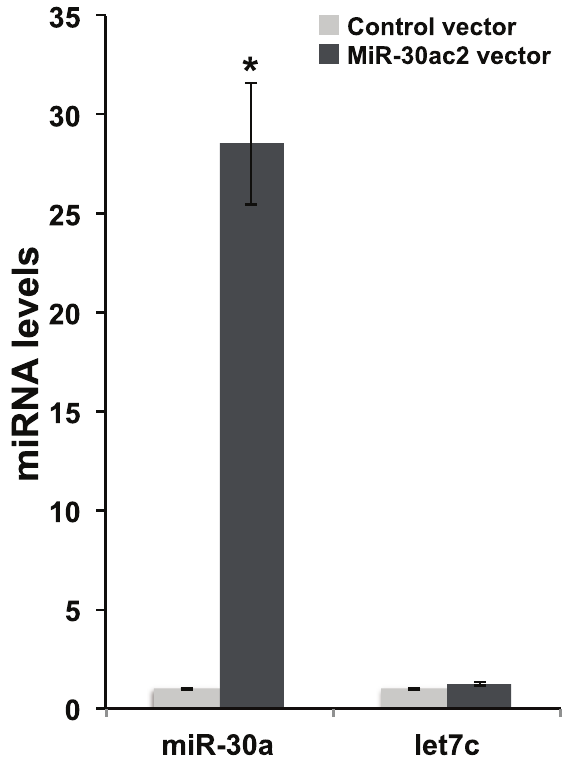
Figure 1. Over-expression of miR-30ac2 in HEK293FT cells. A plasmid encoding miR-30a cluster miRNAs (miR-30a and miR-30c2) or a scrambled miRNA sequence was transfected into HEK293T cells. The resulting levels of miR-30a and let-7a were measured by qRT-PCR. Error bars indicate the standard error of the mean. * p < 0.05. The data represent three separate transfections, each with three technical replicate